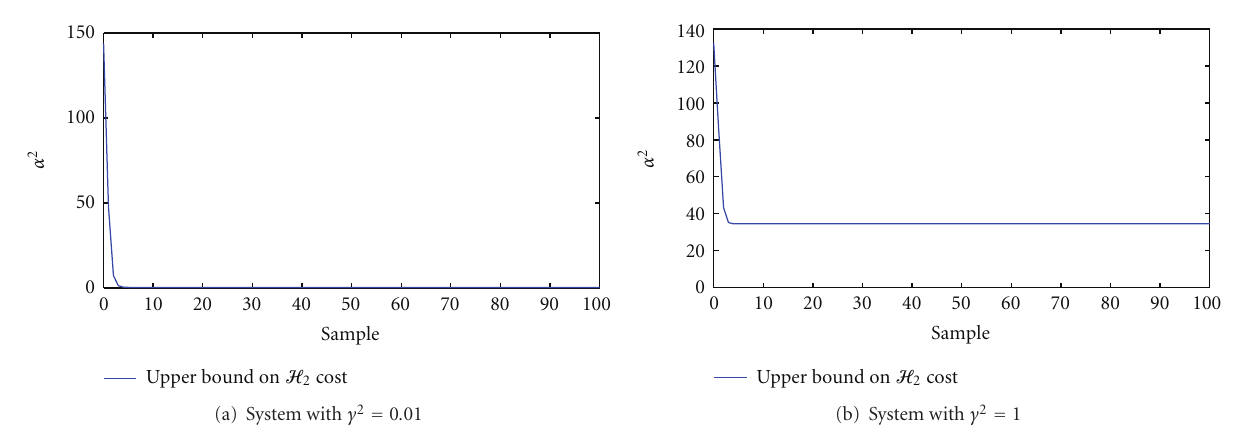
Figure 6: Upper bound on H 2 cost function for solenoid